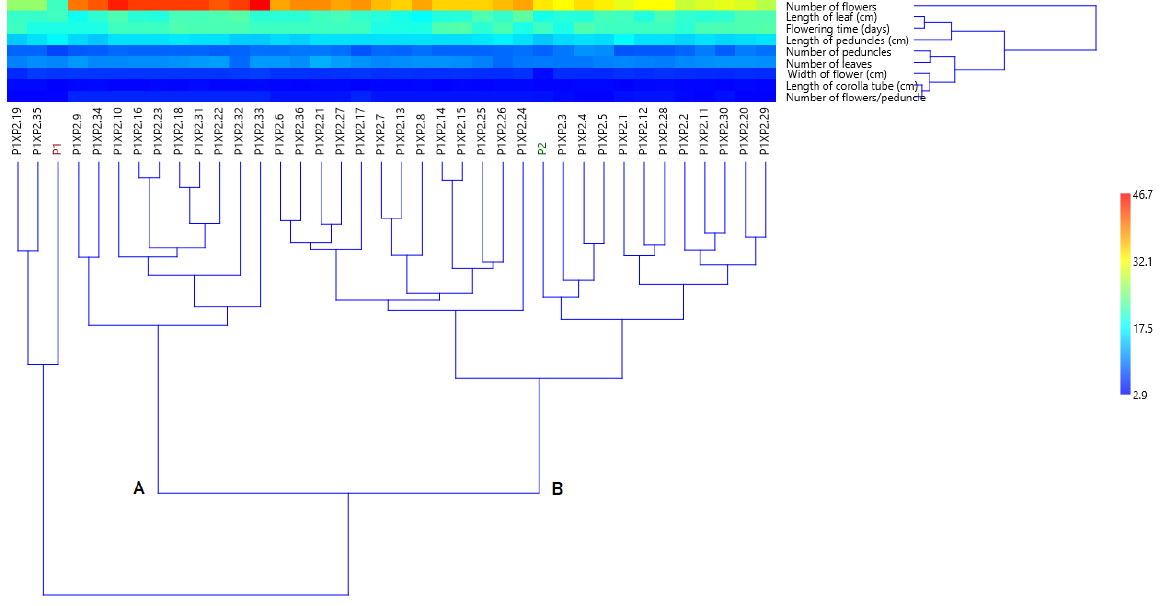
Figure 5. Two-way UPGMA dendrogram based on morphological traits, showing the relationships between parents (P1 and P2) and F 1 plants from P1×P2 cross and based on Euclidean’s distance index. In dendrogram, the mother parent is marked with red color, while the father parent is marked with green color.